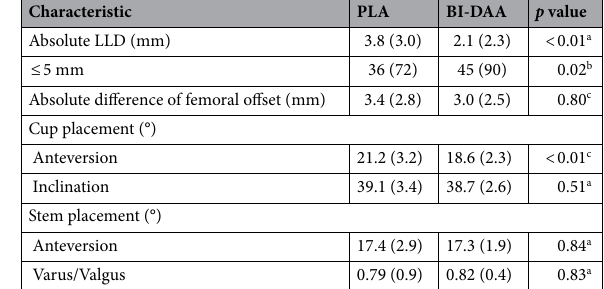
Table 3. Radiographic measurements. Values are n (%) or mean (SD). p value < 0.05 considered statistically significant. LLD leg length discrepancy; SD standard deviation. a Student’s t test; b Chi-squared test; c Mann– Whitney